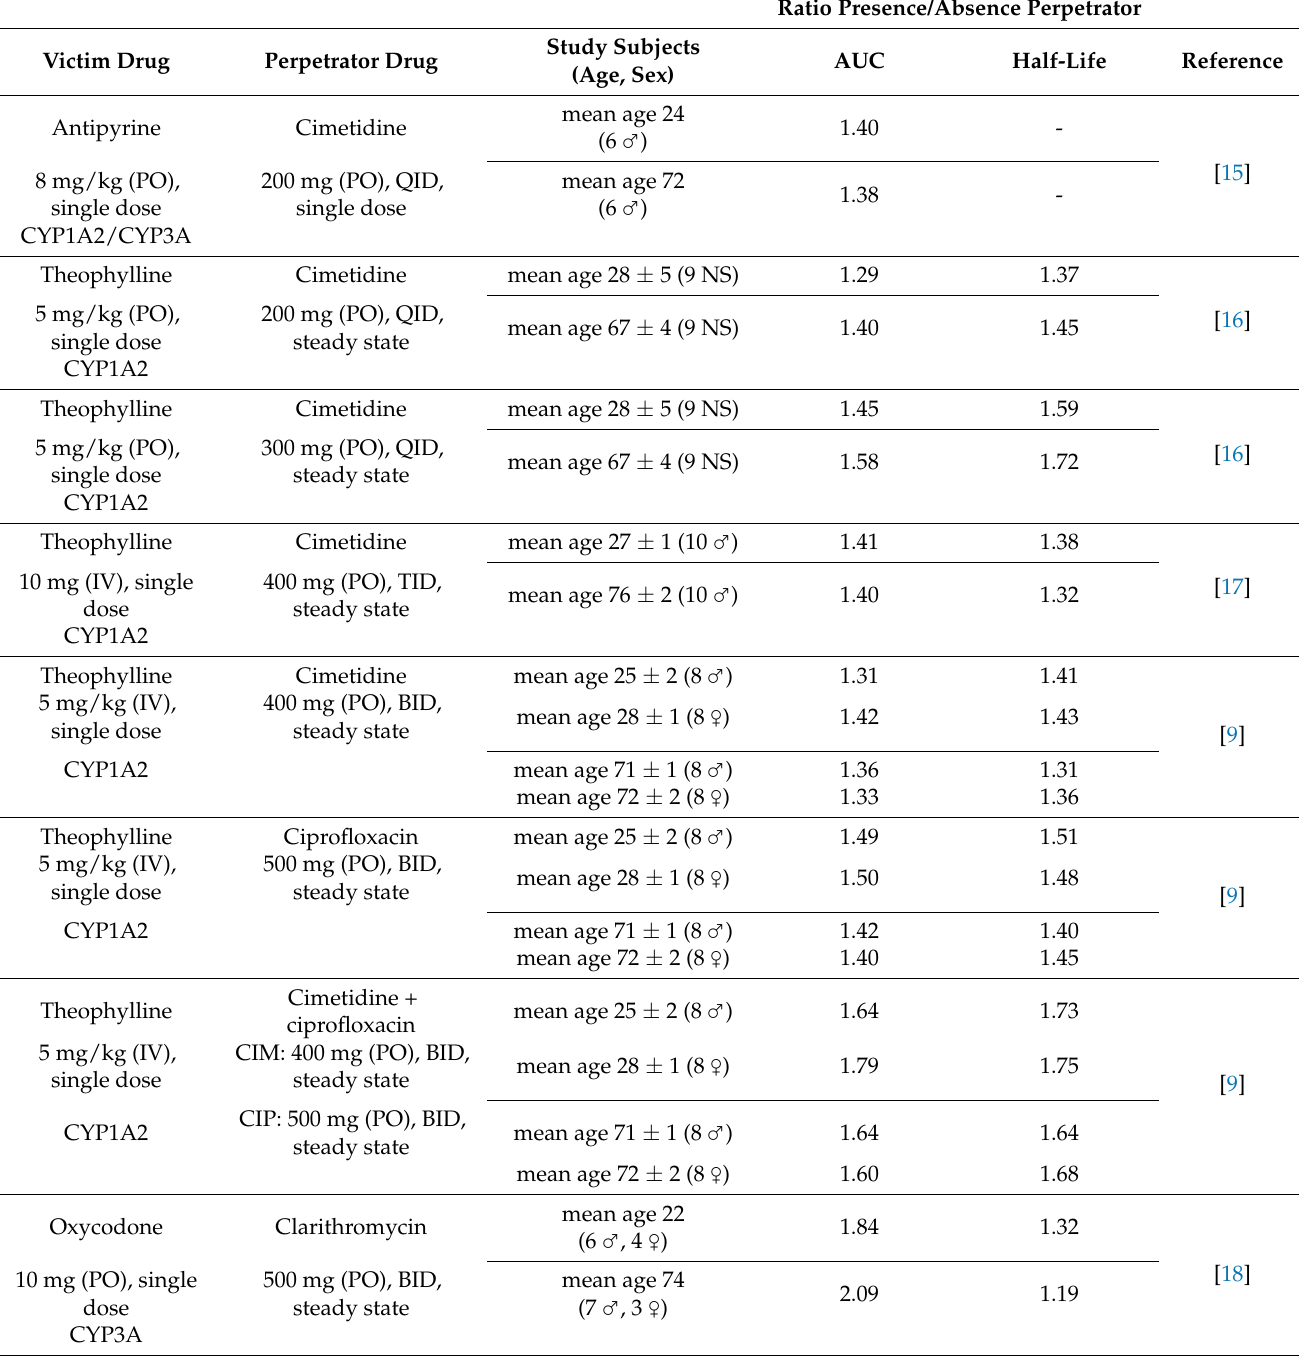
Table 2. Comparison of DDI magnitudes with inhibitors impacting drug metabolism in elderly individuals relative to young